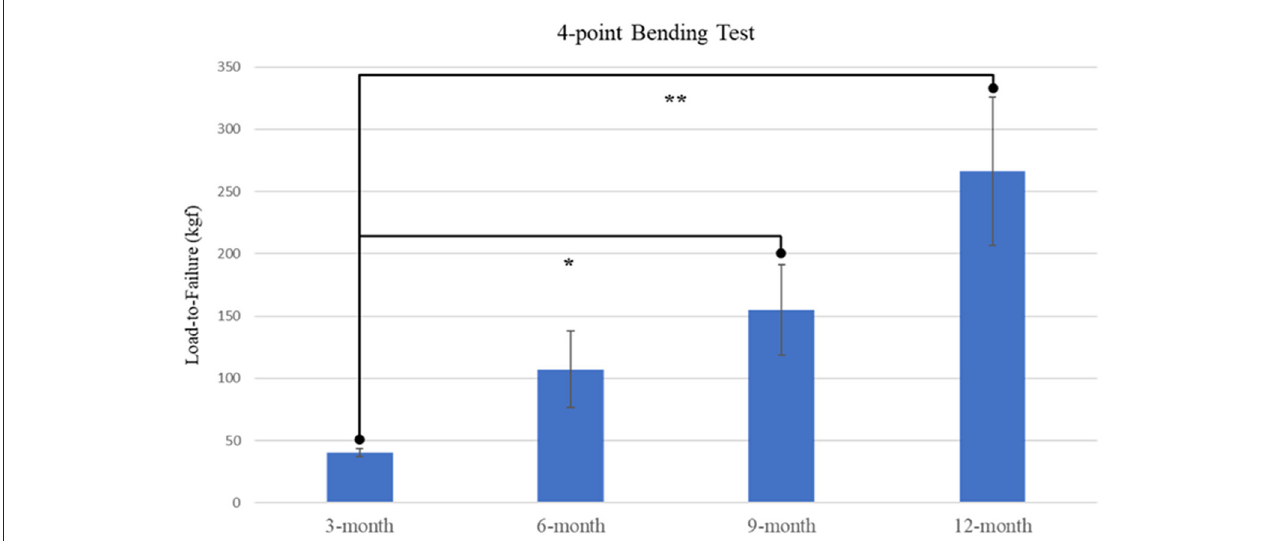
FIGURE4 Plot of load-to-failure forces for samples at 3-, 6-, 9-, and 12-month time points. Significant differences observed between 3-month and both 9-month and 12-month samples are denoted by * and ** respectively.